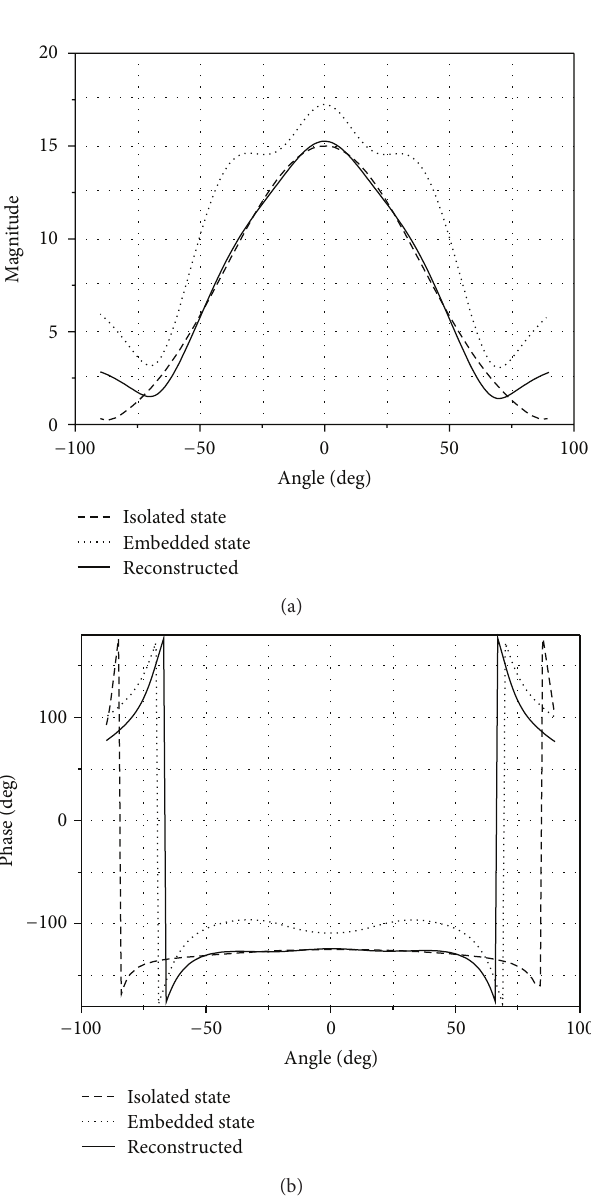
Figure 4: Pattern reconstruction of 𝐸 𝜑 for element number 3 at 2.65 GHz, (a) magnitude and (b)